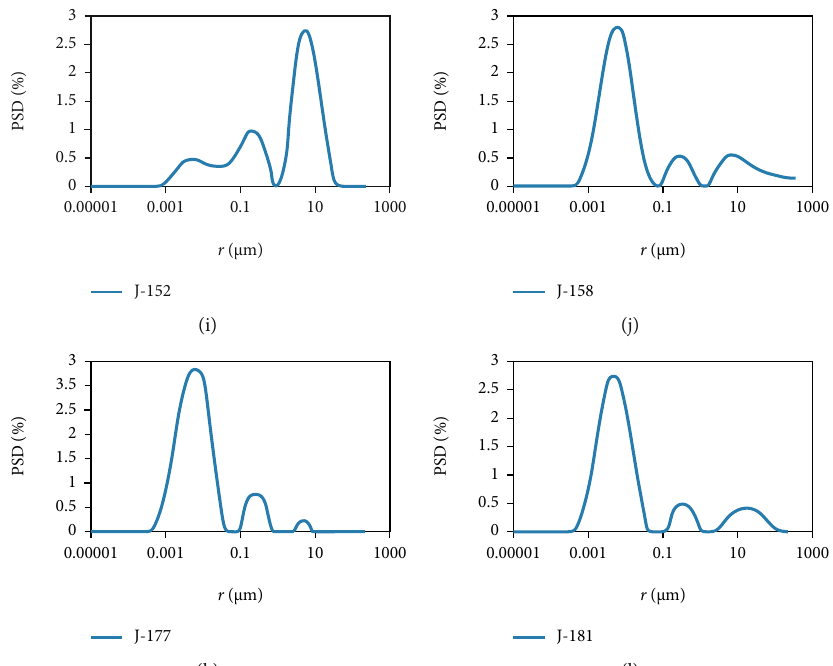
Figure 8: NMR T spectra of the Lucaogou Formation, Jimusar Sag. (a) Well J10025, 3673.42 m, dolomitic mudstone with abundant organic 2 matter and obvious dolomitization. Nanoscale pores ( < 1 μ m) are present with a pore size of 1 – 100nm. (b) Well J10025, 3487.21m, well- sorted dolomitic siltstone containing rounded minerals. Intergranular pores are completely cemented by calcites and dolomites. The strong compaction and cementation have resulted in an extremely small pore size (i.e., nanopores; < 1 μ m), with the main pore size range being 1 – 40 nm. (c) Well J10025, 3537.1m, dolomitic siltstone with evenly distributed dolomite, feldspar, and quartz. The main pore size range is 0.001 – 10 μ m. (d) Well J10025, 3506.1m, mudstone containing a large carbonate vein and cracks. The pore size range